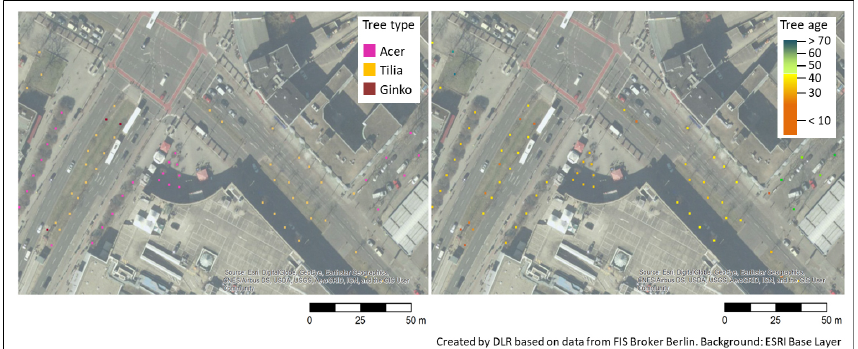
Figure 7. Tree species (left) and tree age (right) of municipal trees in Berlin source: FIS Broker (dl-de/by-2-0: https://www.govdata.de/dl-de/ by-2-0, last access: 26 October 2020)